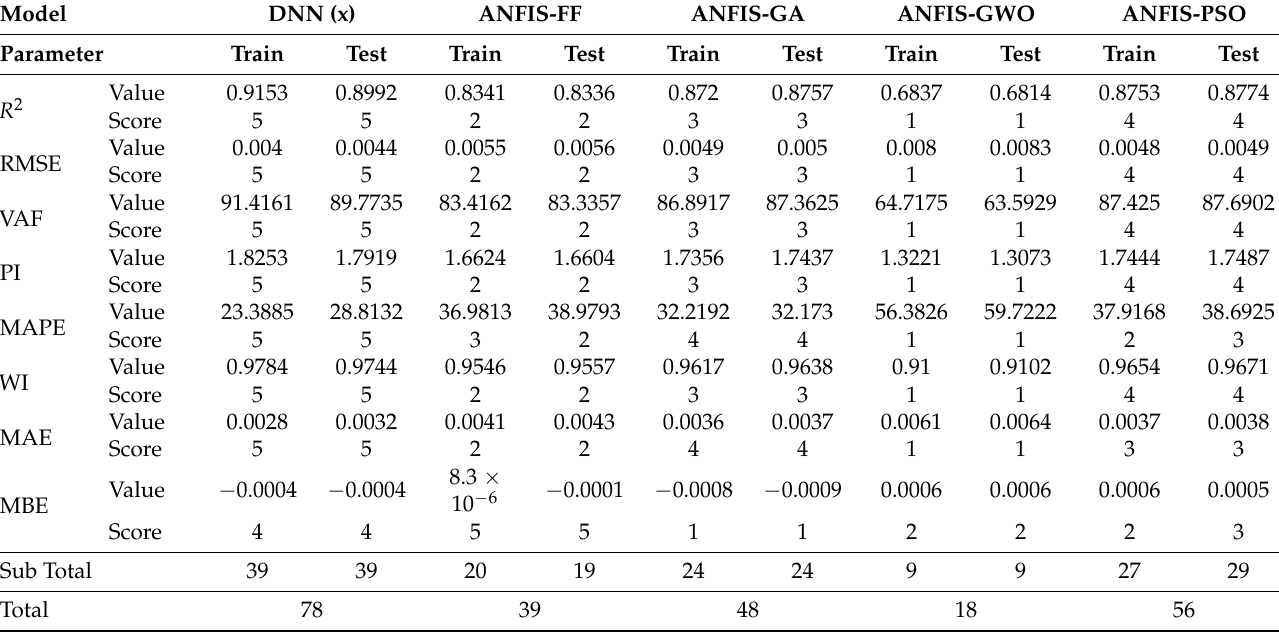
Table 1. Statistical parameter of all the models in lateral ( x ) direction.